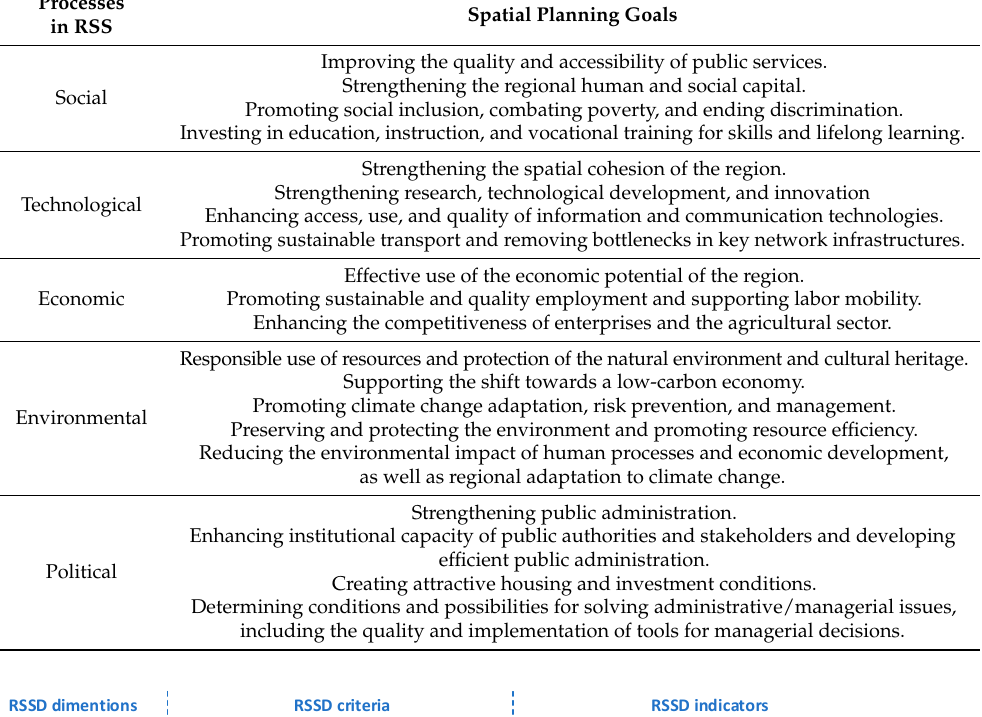
Table 2. Problems structure for spatial planning.